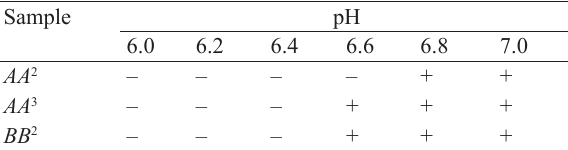
Table 9 Thermal stability of reconstituted dried milk from cows with different CSN3 genotypes by heat